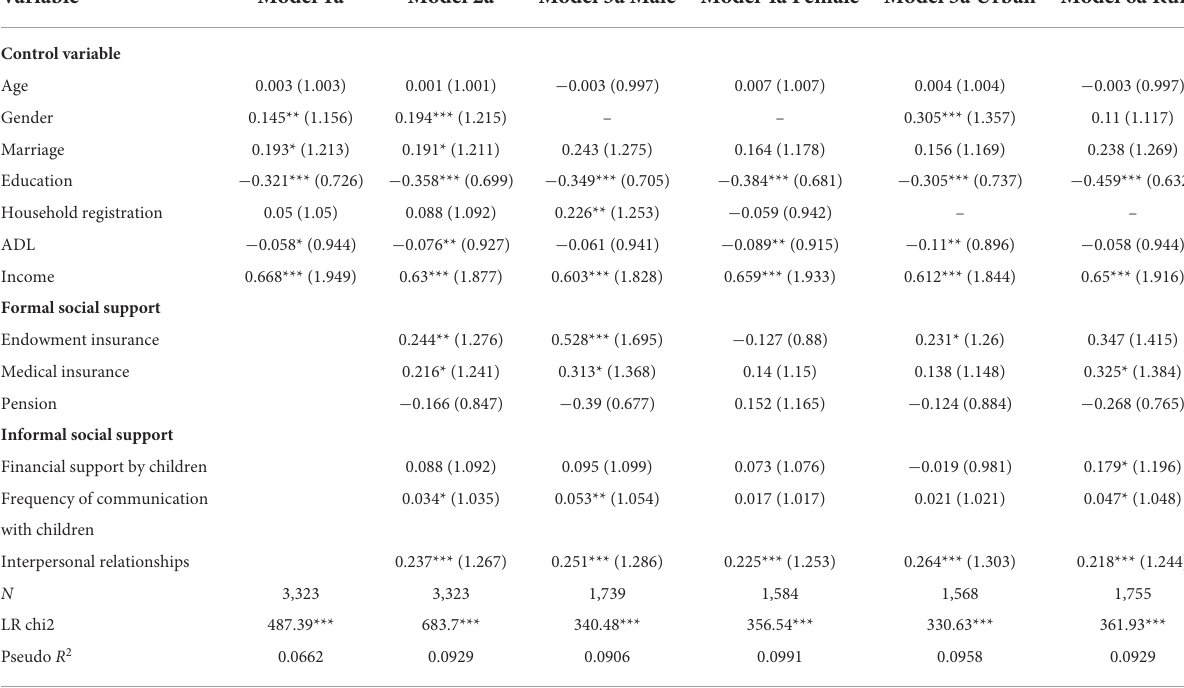
TABLE 2 The impact of formal and informal social support on life satisfaction.